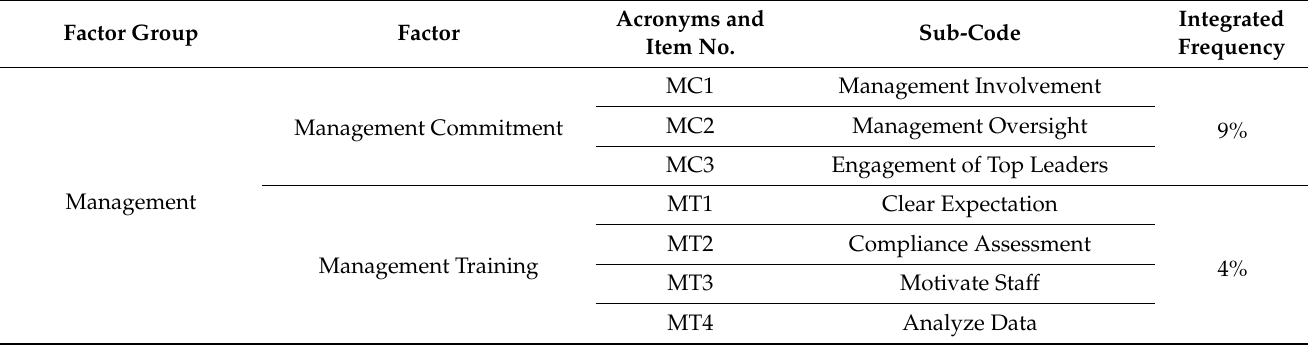
Table 1. Preliminary factors and their